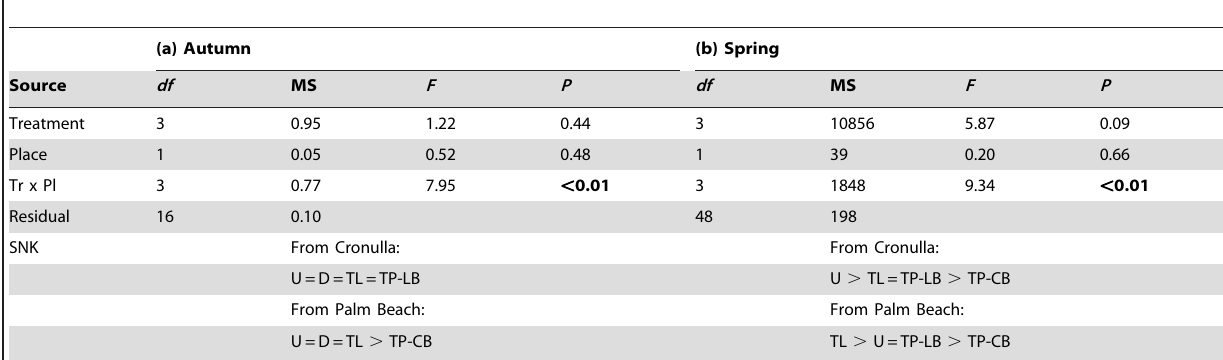
Table 2. Analyses of length of Phyllospora at the end of the (a) first and (b) second experimental transplants.